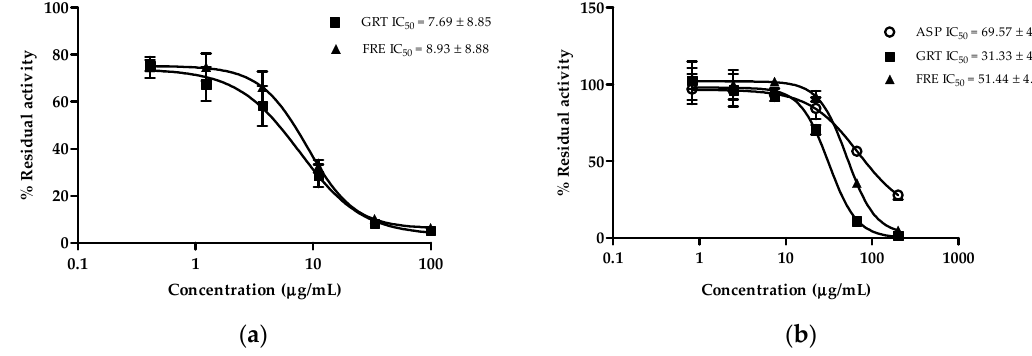
Figure 3. Percentage remaining activity of ( a ) CYP2C8 and ( b ) CYP3A4 after 30 min co-incubation with ASP (aspalathin), GRT (unfermented rooibos extract) and FRE (fermented rooibos extract) with NADPH and substrates. Data are the average values of two independent assays done in duplicate ( n = 4).